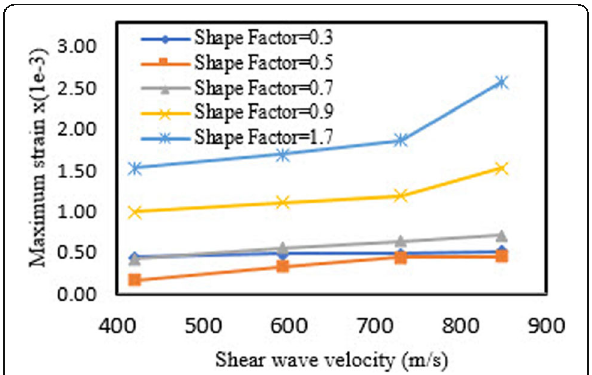
Fig. 12 Maximum strain of pipelines vs. shear wave velocity of soil medium by SF